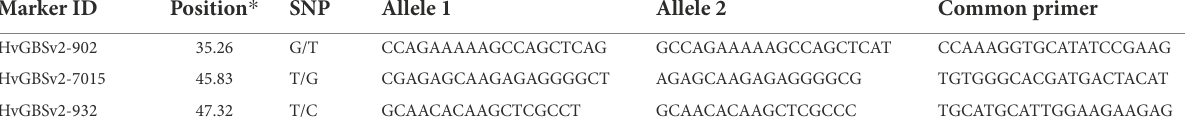
TABLE 2 Sequence information for polymorphic KASP primers used to map RphAGG396 .